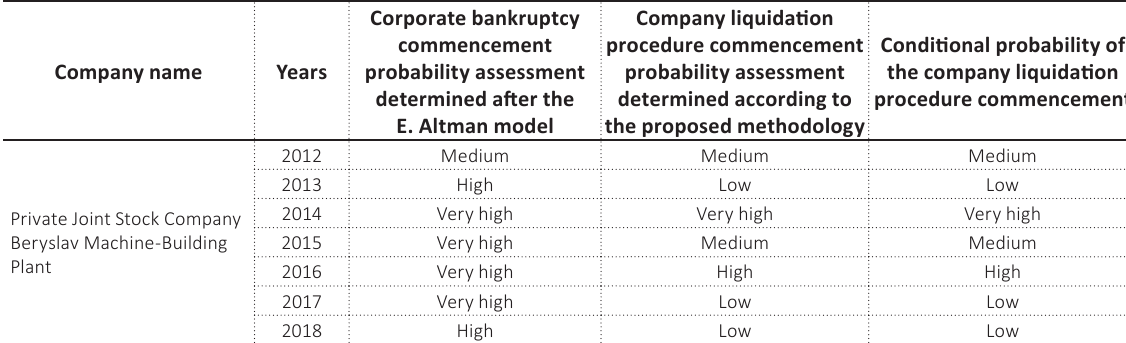
Table 8. Pairwise comparison of the qualitative assessment results for the companies’ bankruptcy procedure commencement probability and that for their liquidation procedure